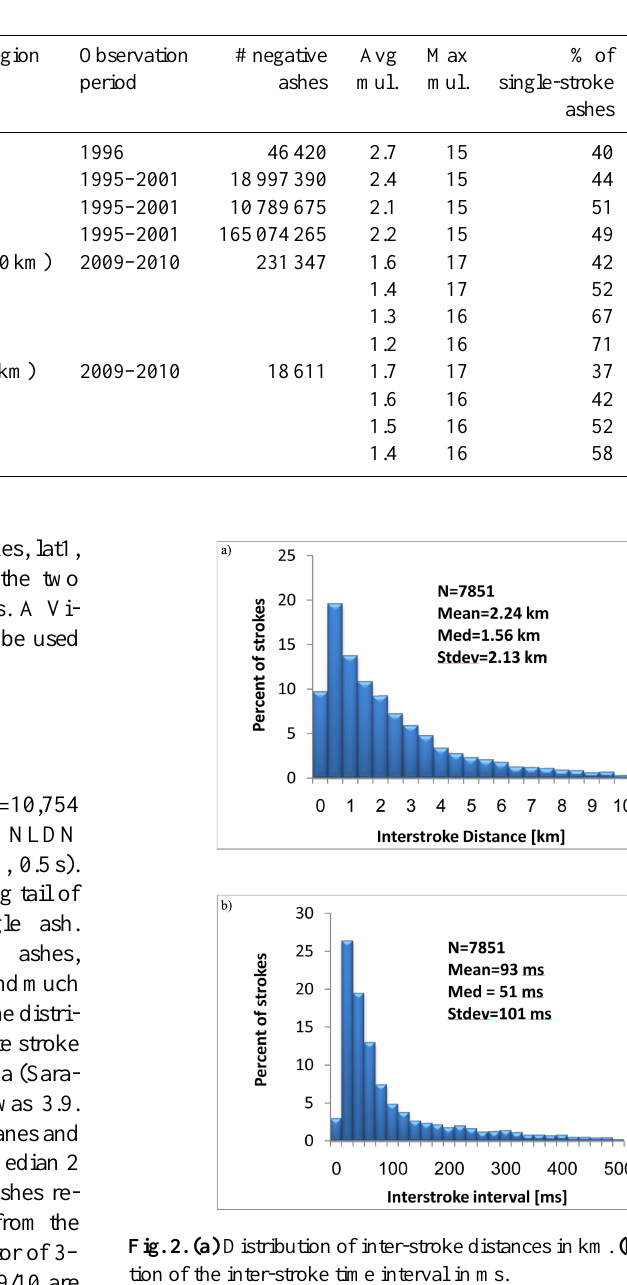
Table 1. Average multiplicity, maximum multiplicity and percentage of single-stroke flashes based on data from different lightning detection networks. Reproduced from Rakov and Huffins (2003)